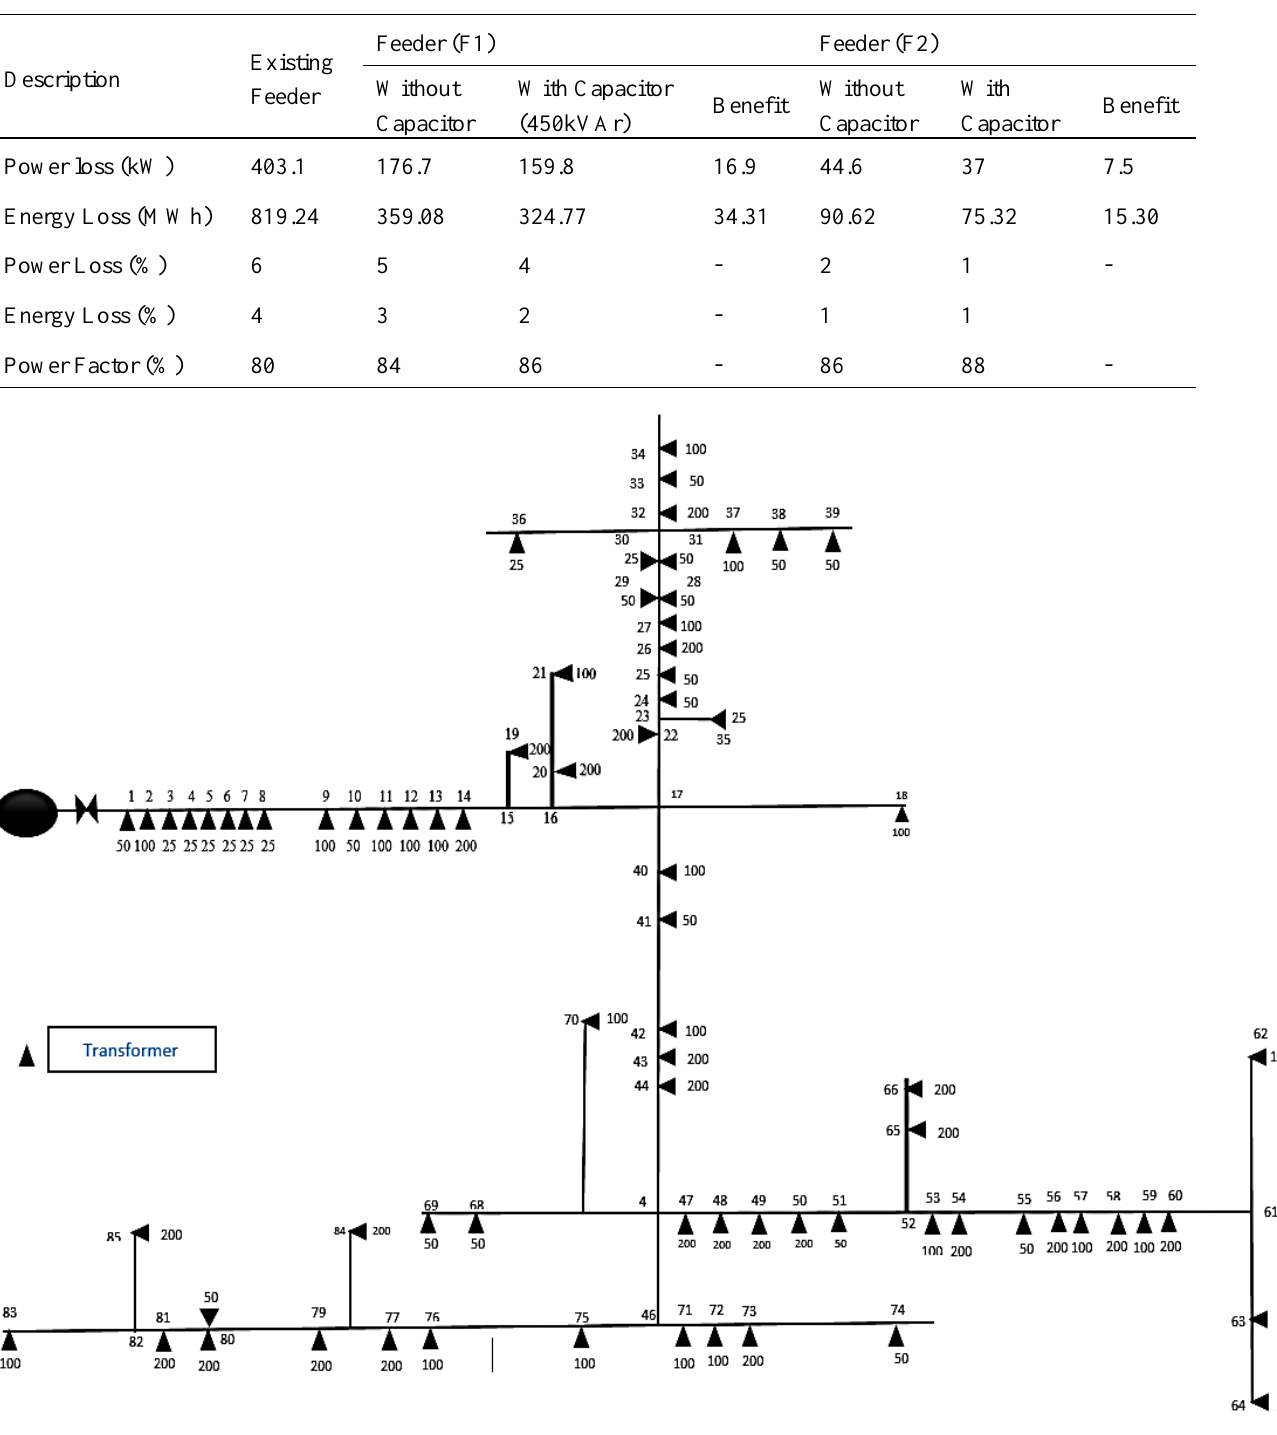
Results comparison for existing and proposed feeder